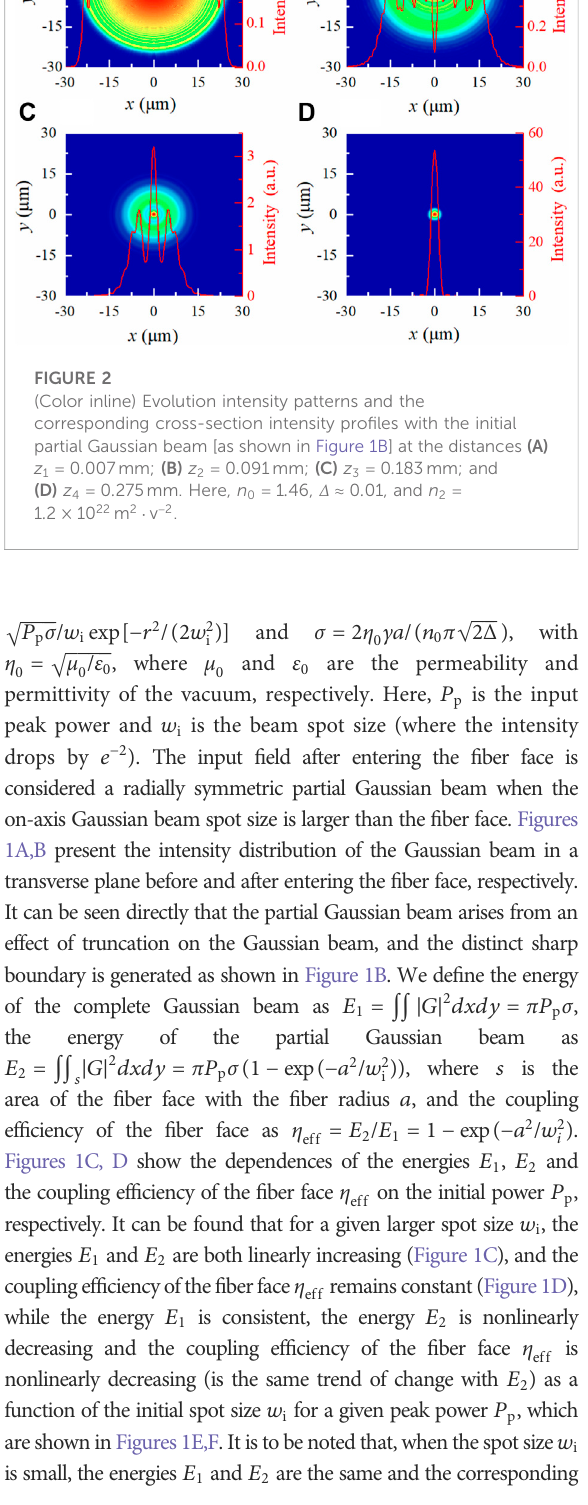
P w (cid:2) p for a given i